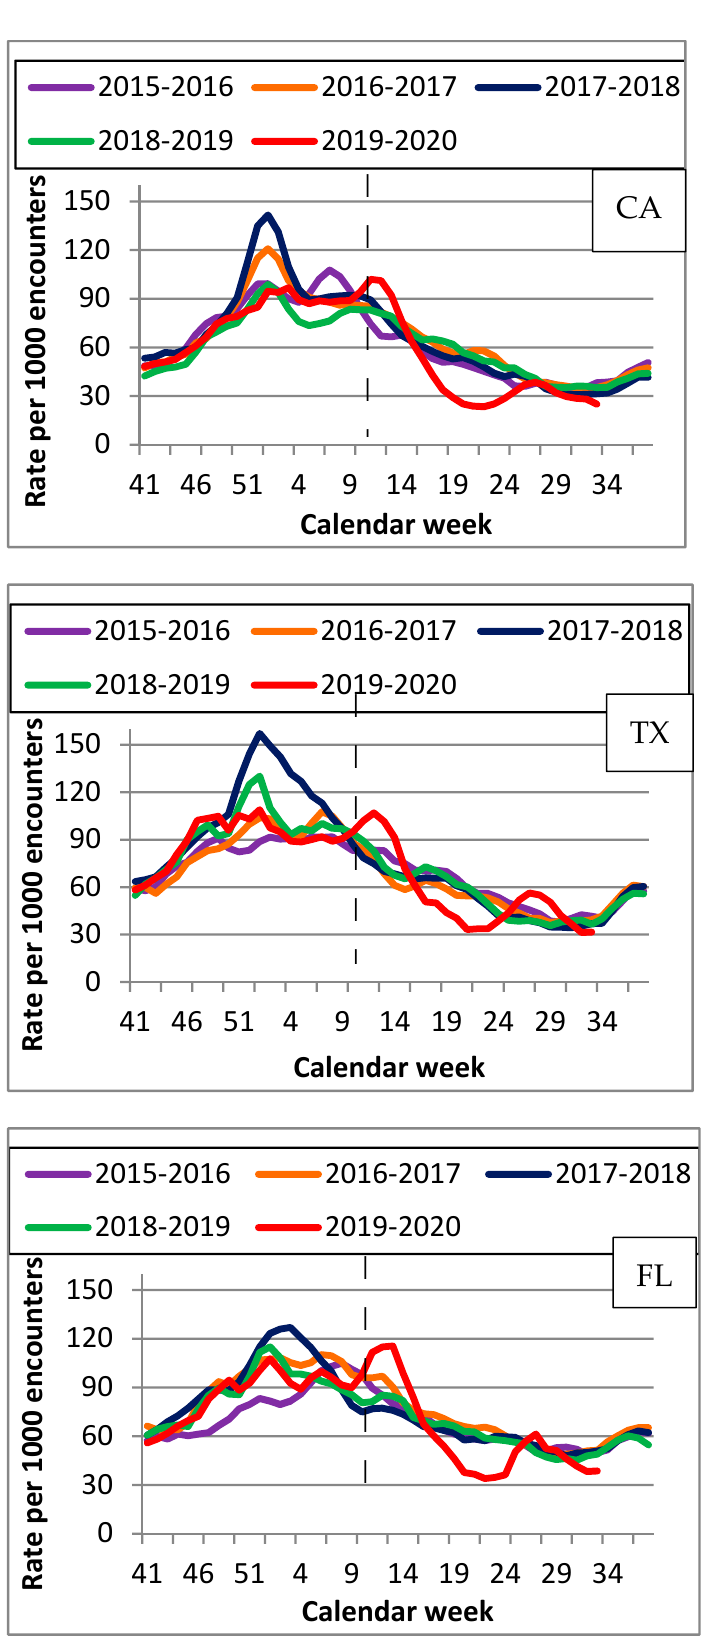
Figure 3. Rates per 1000 ED encounters for non-influenza ILI by state (CA, TX, FL) for 5 flu seasons (2015–2020).